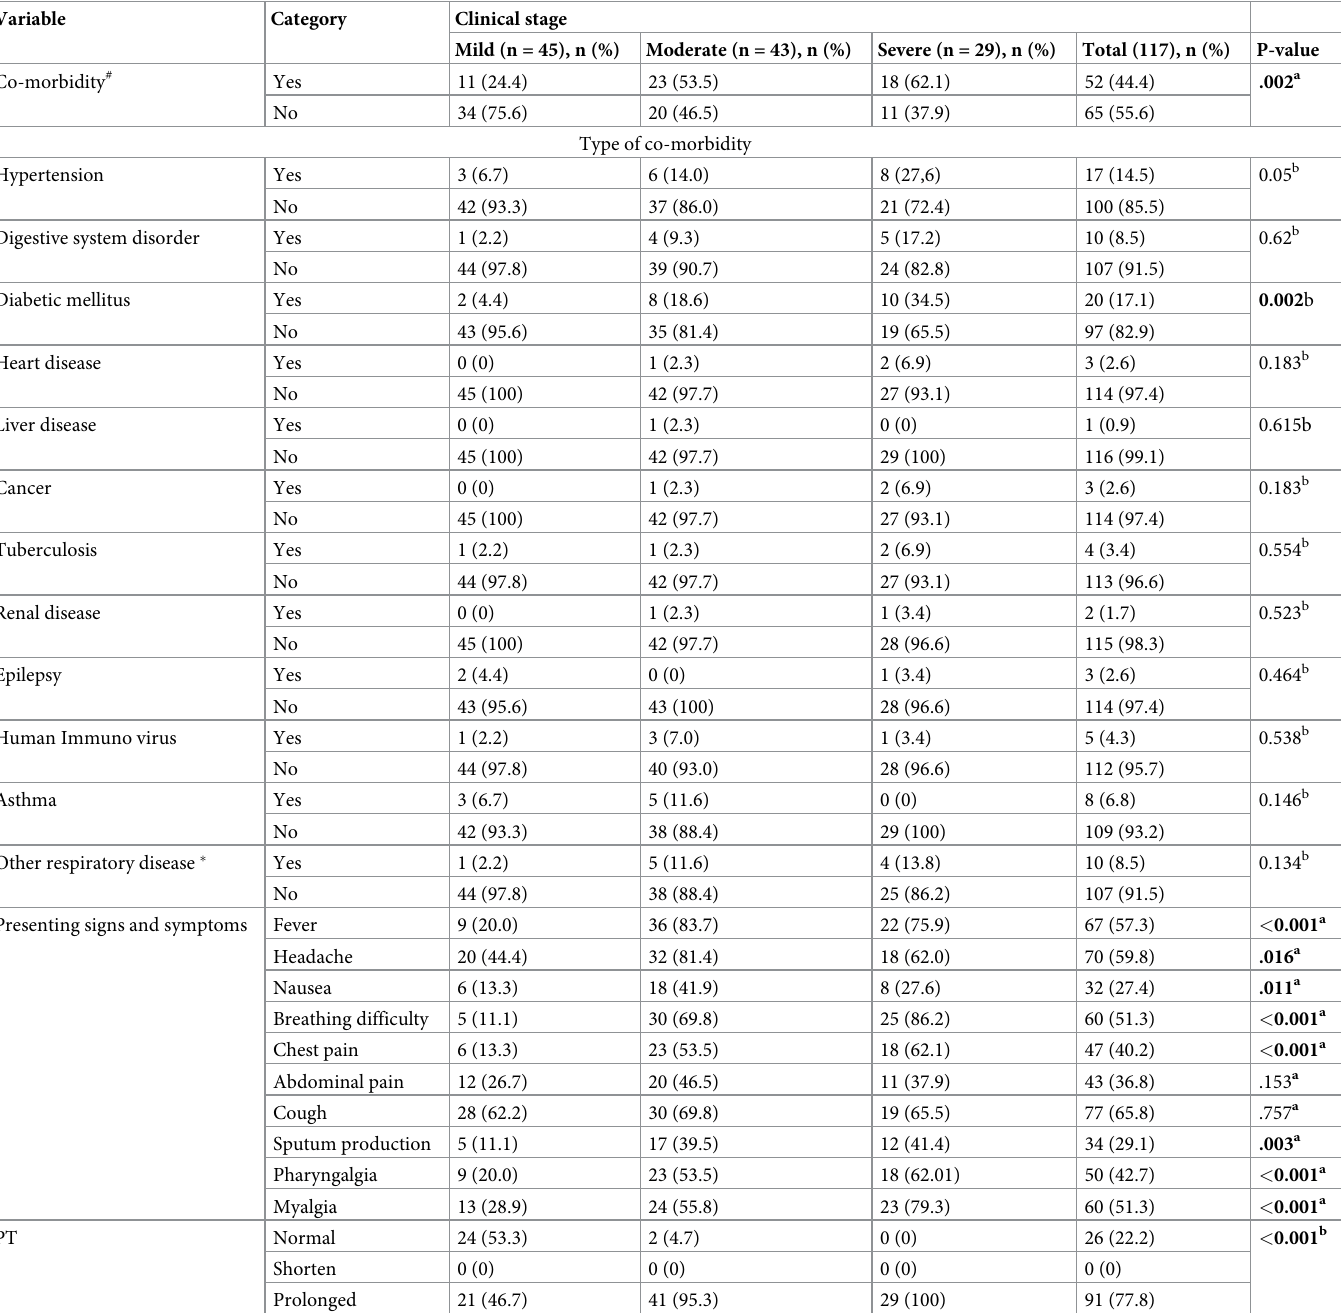
Table 2. Clinical characteristics of the study participants attending at the Tibebe Ghion Specialized Hospital, COVID-19 treatment center 2021 (n = 117).